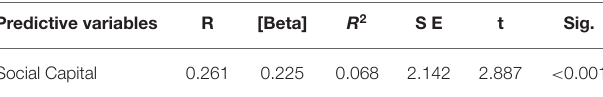
TABLE 6 | Regression and effect coefficients of socio-demographic variables in social capital. Predictive